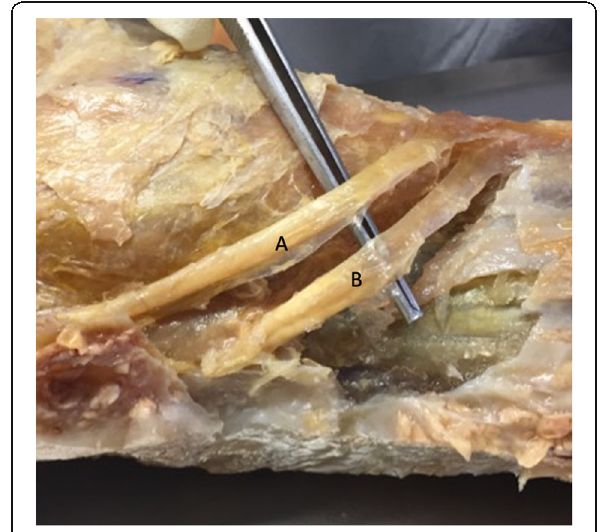
Fig. 1 Hamstring specimens Preparation/ A = Gracilis tendon / B = Semi-Tendinosus